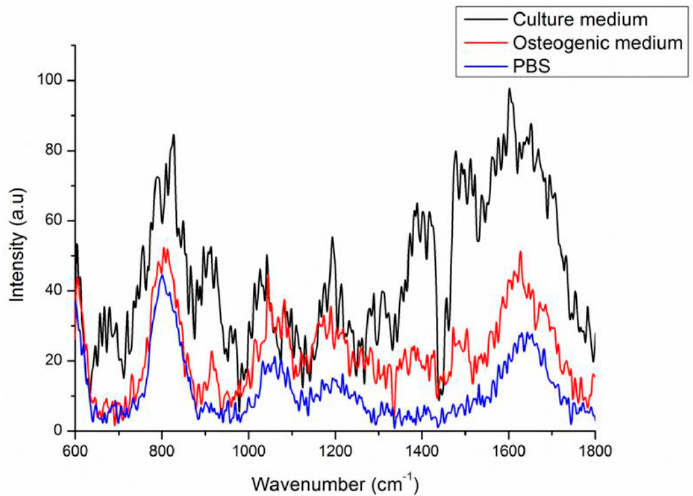
Figure 3. Raman spectra of background signals of quartz coverslips with culture medium, osteogenic induction medium, and PBS.